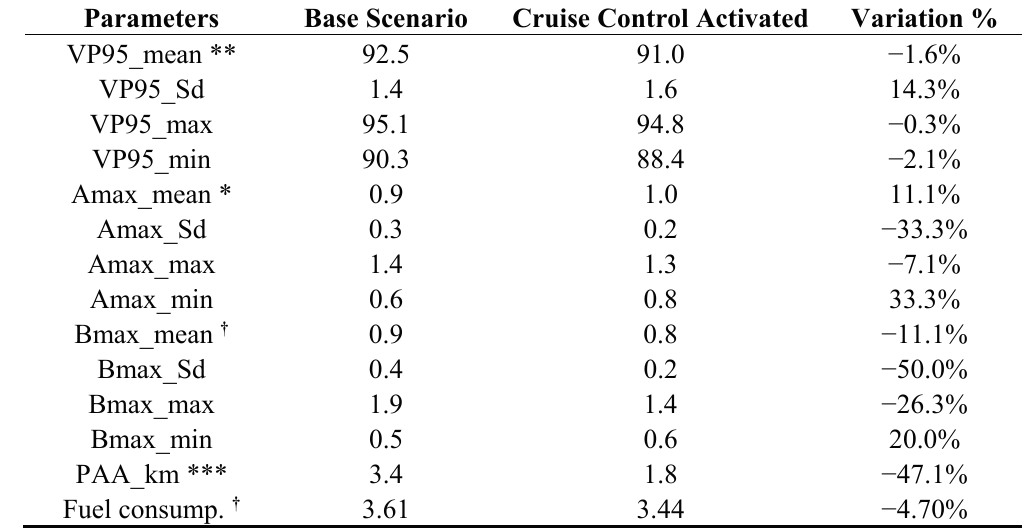
Table 5. Changes in vehicle trajectory variables produced by the use of a Cruise Control